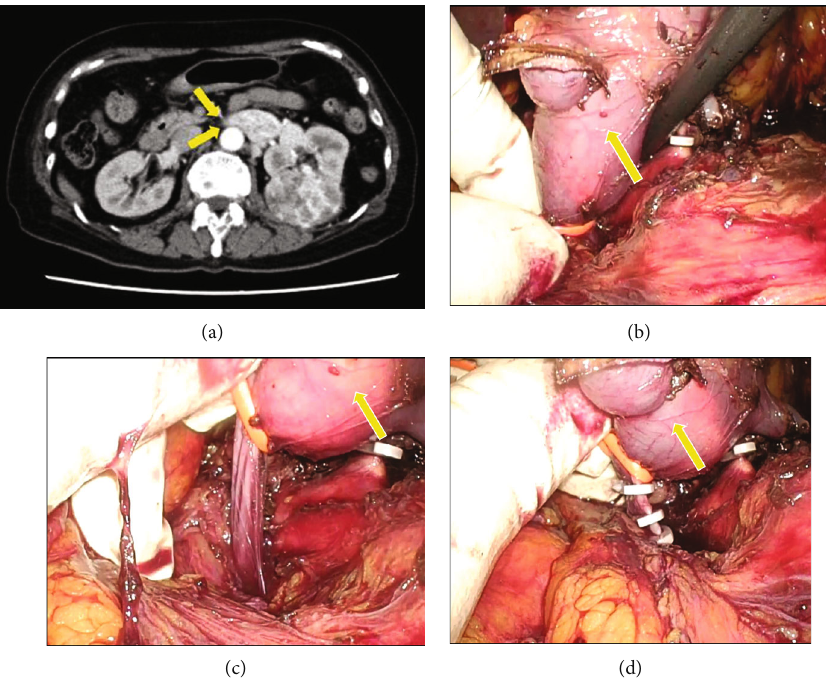
Figure 4: Imaging and intraoperative fi ndings of the cases with left renal cell carcinoma with thrombus (case 3). (a) Computed tomography demonstrated a thrombus extending 2mm beyond the right aortic border. (b) A vessel loop hooked to the thrombus tip. (c) The thrombus was pulled up using a vessel loop. (d) The left renal vein was dissected using Hem-o-lok clips. Arrowheads indicate the tip of the tumor